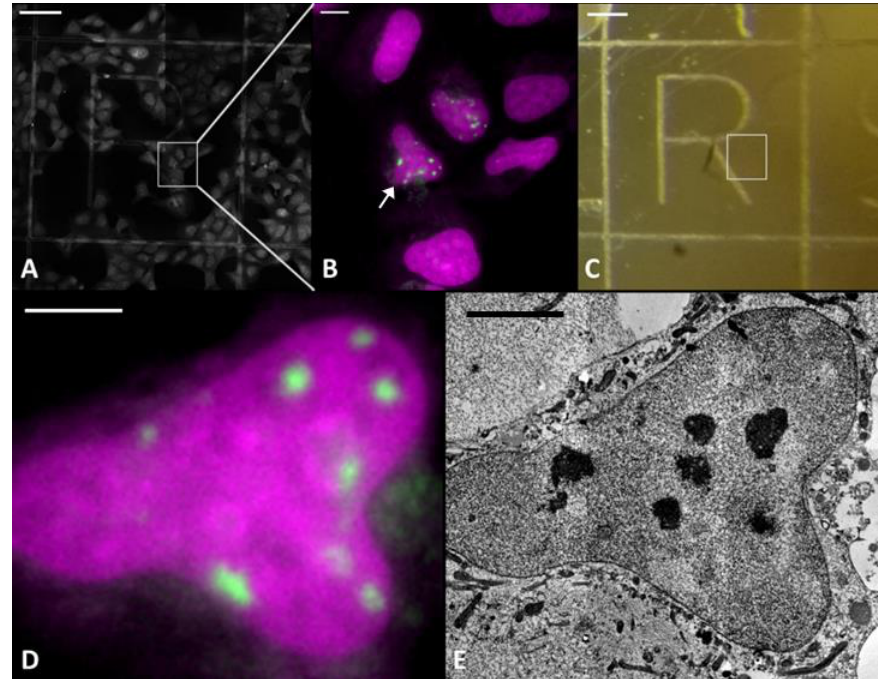
Figure 1. Defining region of interests (ROIs) and relocalization (CLEM): Fluorescence mosaic imaging of the whole grid was done automatically with a 20× dry lens ( A ). ROIs were defined by 53BP1-GFP expressing cells showing radiation induced repair foci ( A , B and D ) and imaged again at higher resolution using a 63x oil immersion objective ( B ). After the cells were embedded and removed from the glass coverslip, the resin block shows the imprint of the grid ( C ) and the ROI can be relocated (white box). Next, 100 nm sections were stained with UA and by the aid of the imprinted grid cells were relocated in the cut sections allowing imaging of the same nucleus in EM. FM ( B arrow, D ) and TEM ( E ). Scale bar: A & C 100 µm; B 10 µm; D & E 5 µm.